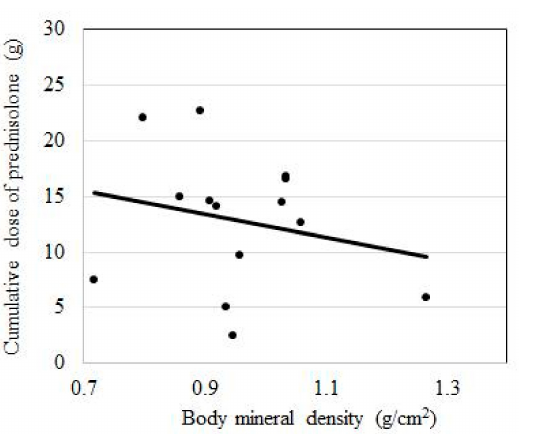
Figure 2. Relationship between cumulative prednisolone (PSL) and body mineral density ( r = − 0.028, p =